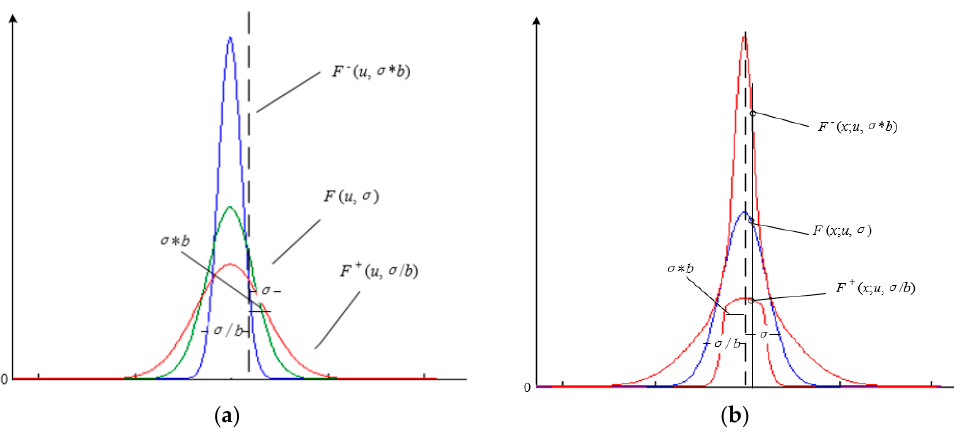
Figure 3. Interval type-2 fuzzy model with uncertain standard deviation. ( a ) Type-1 fuzzy membership function with uncertainty of vertical direction; and, ( b ) Interval type-2 fuzzy membership function.